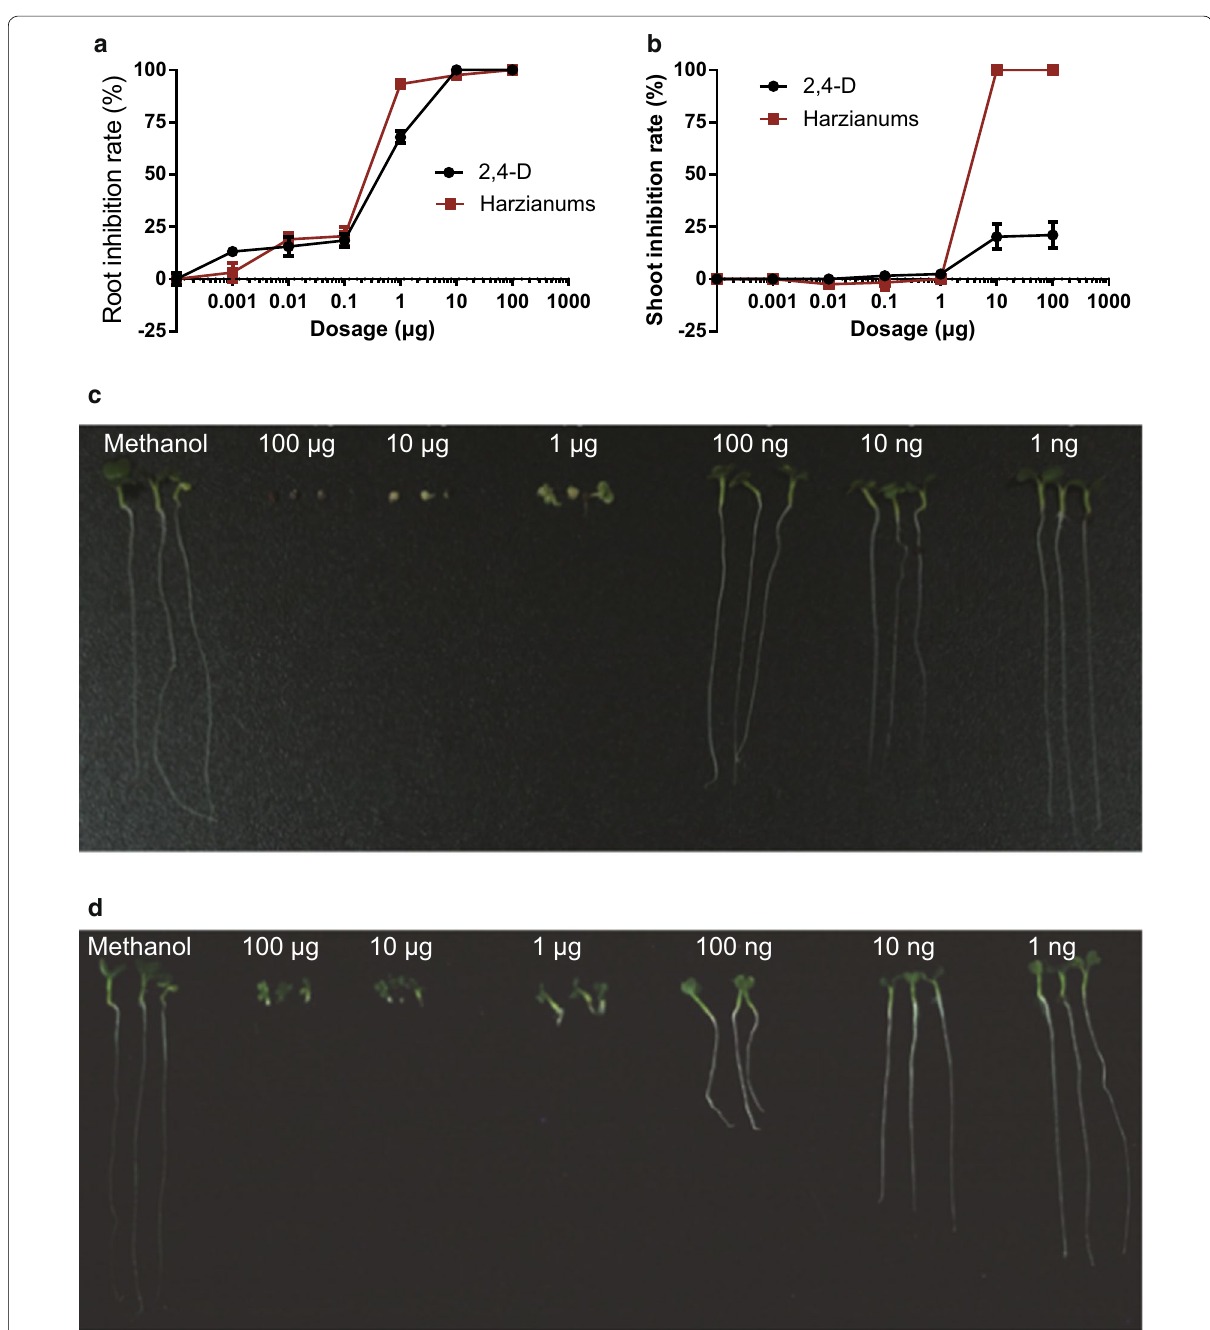
Fig. 1 The phytotoxic effect of HA and HB ( 1 – 2 ) on B. chinensis compared to the positive control, 2,4-D. The inhibition rate of a root or b shoot length by HA and HB or 2,4-D (n 5). The photographs of B. chinensis seedlings after treatment with c HA and HB or d =